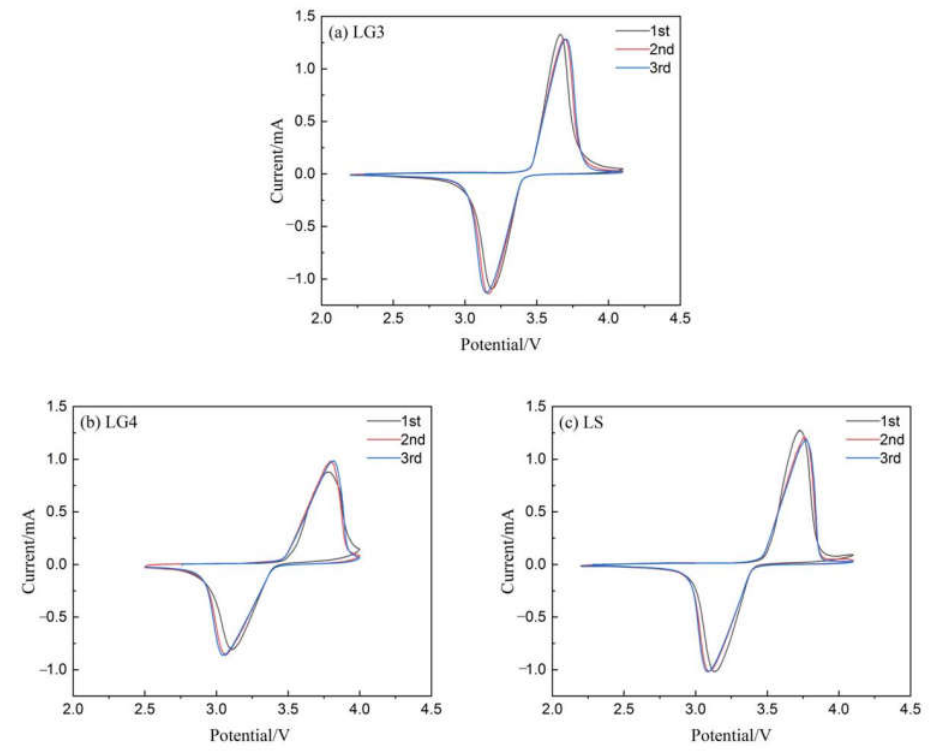
Figure 9. The cyclic voltammograms of the assembled lithium batteries.